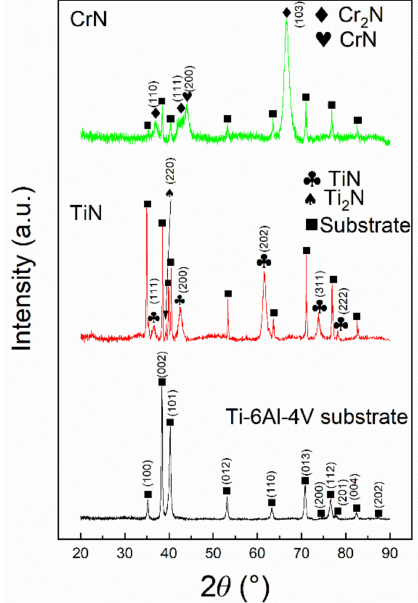
Figure 5. XRD profile of the CrN coating, TiN coating, and Ti-6Al-4V substrate.